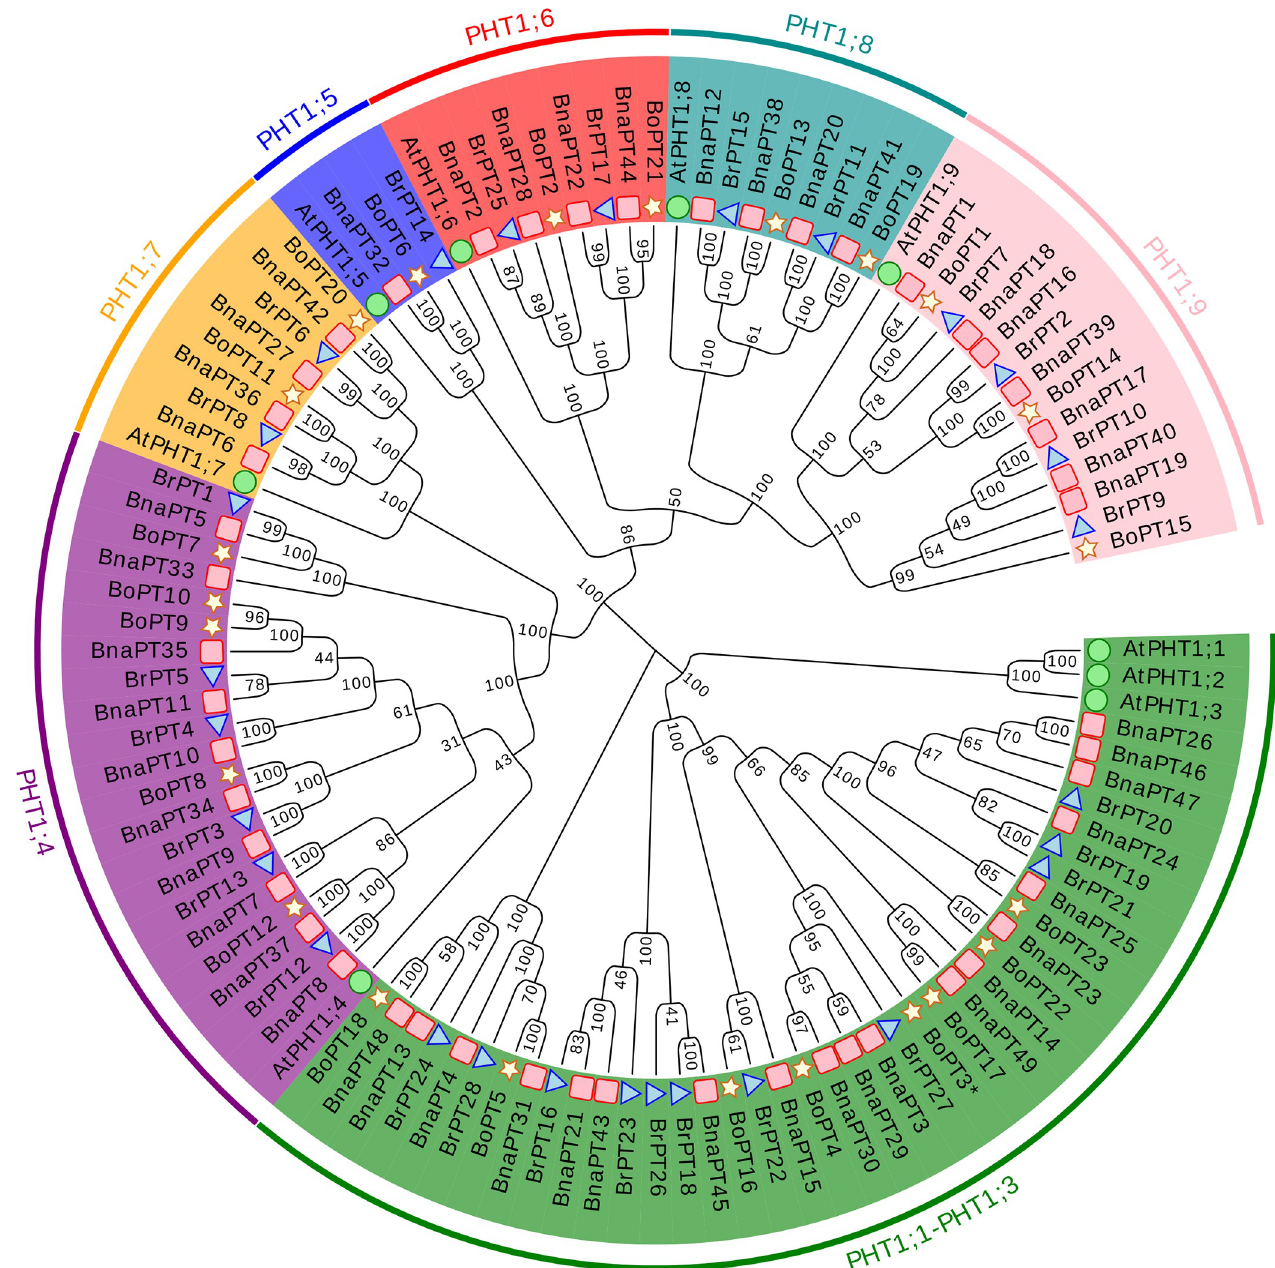
Fig 1. Phylogenetic tree of coding nucleotide sequences of the phosphate transporter family 1 (PHT1) in Brassica napus , B . oleracea , B . rapa and Arabidopsis thaliana . The phylogenetic tree was constructed by MEGA 5.1 with neighbor-joining method and 1000 replicates. The analysis involved 109 nucleotide sequences including 49 from B . napus (pink red rectangle), 28 from B . rapa (light blue triangle), 23 from B . oleracea (light yellow star) and nine from Arabidopsis (light green